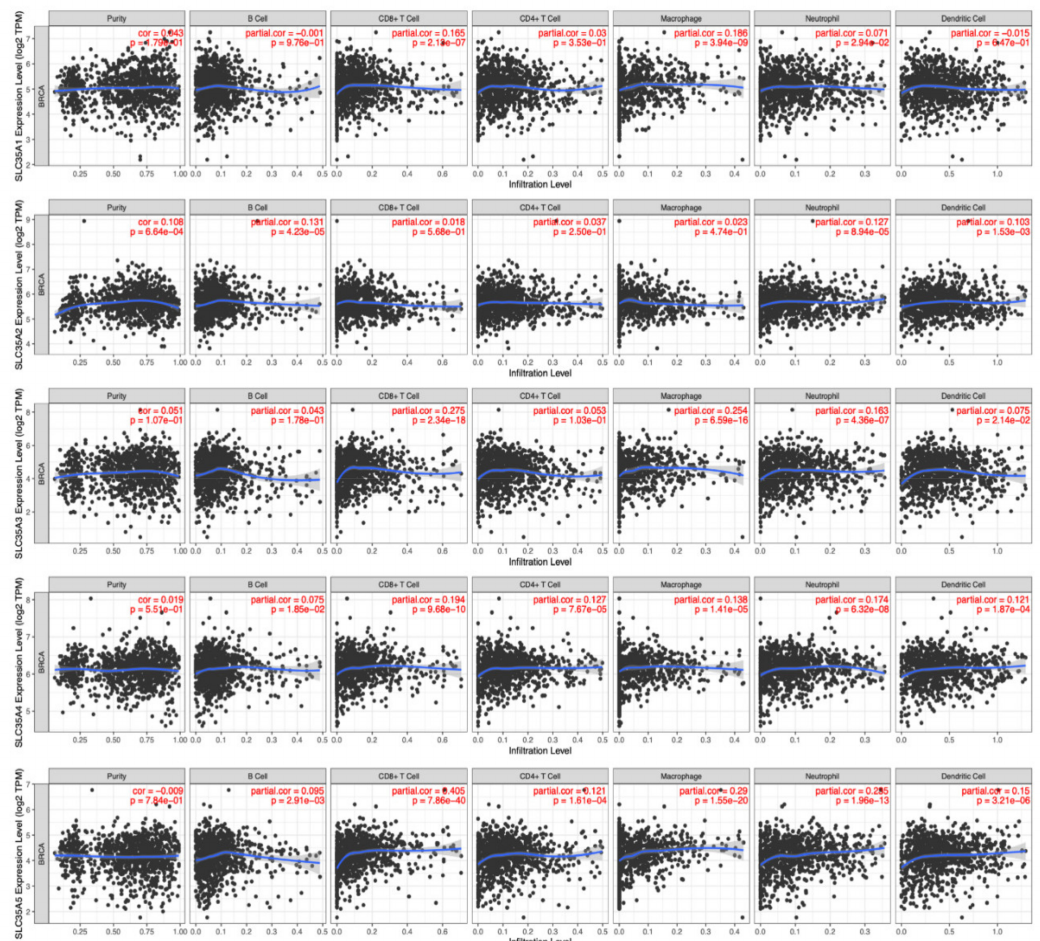
Figure 8. Correlations between solute carrier 35A (SLC35A) family member expressions and immune infiltration profiles of BRCA performed in the TIMER database. The graph shows above respectively depicts the correlations between abnormally expressed gene of SLC35A family and levels of some remarkable tumor-infiltrating immune cell markers, including the lymphoid lineage (B cells, CD4 + T cells, and CD8 + T cells), followed by the myeloid lineage (neutrophils, macrophages, and dendritic cells) ( p <